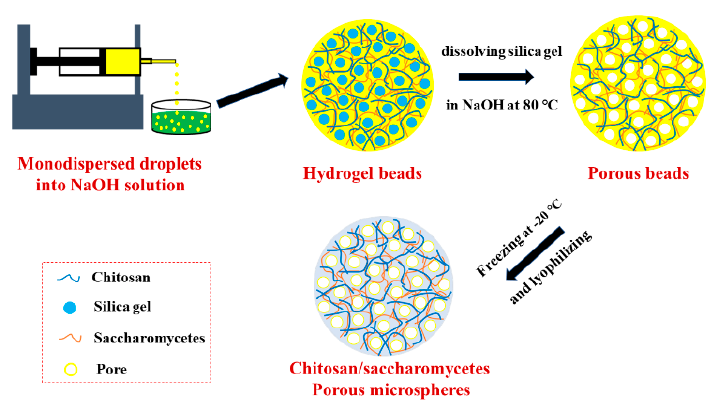
Figure 1. The schematic illustration of porous chitosan/saccharomycetes microspheres preparation process.